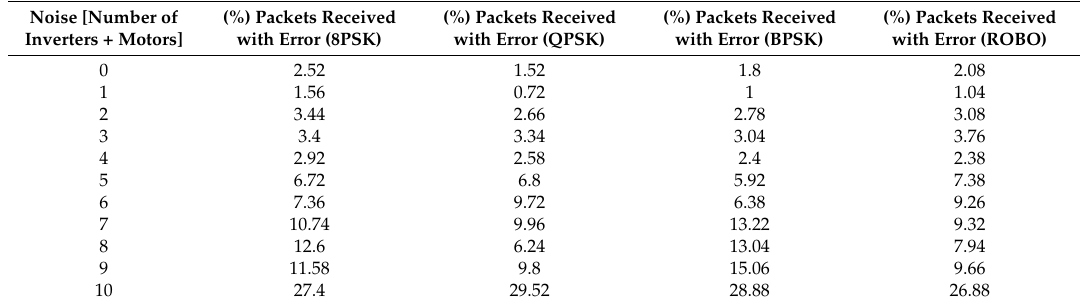
Table 6. Percentage of packets lost during data transmission.